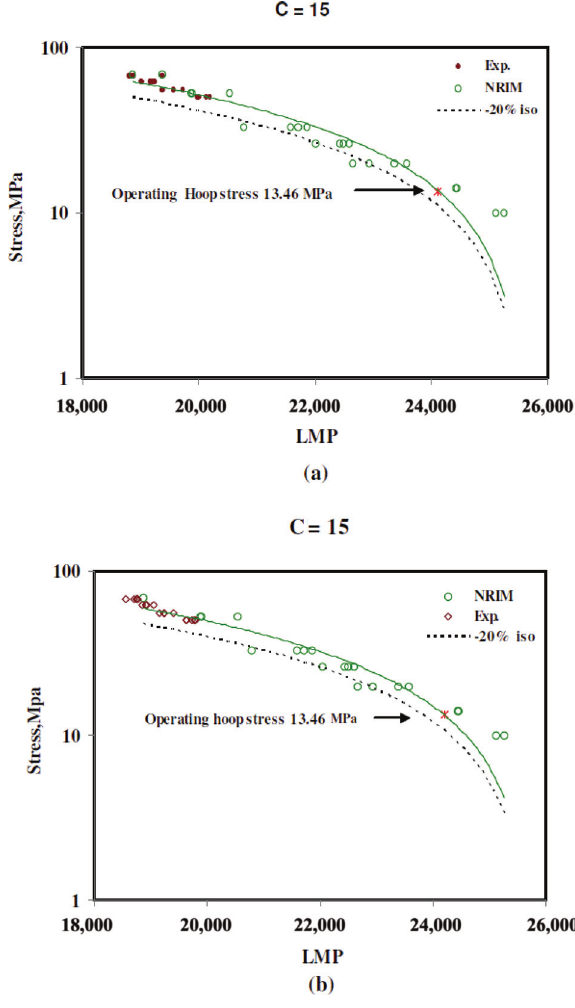
Figure 7: Stress vs LMP Plot for 11 years service exposed Reformer tube materials (a) top and (b) bottom for comparison with – 20% NRIM standard data